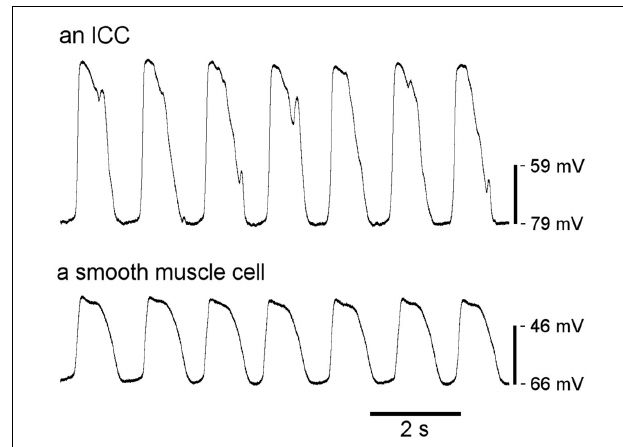
FIGURE 1 |Typical slow wave recordings from an ICC and a SMC from murine small intestine. Slow waves from SMC have a slightly different morphology than those from ICC, including smaller amplitudes. (Courtesy of Dr. Lei Sha, Mayo Clinic).